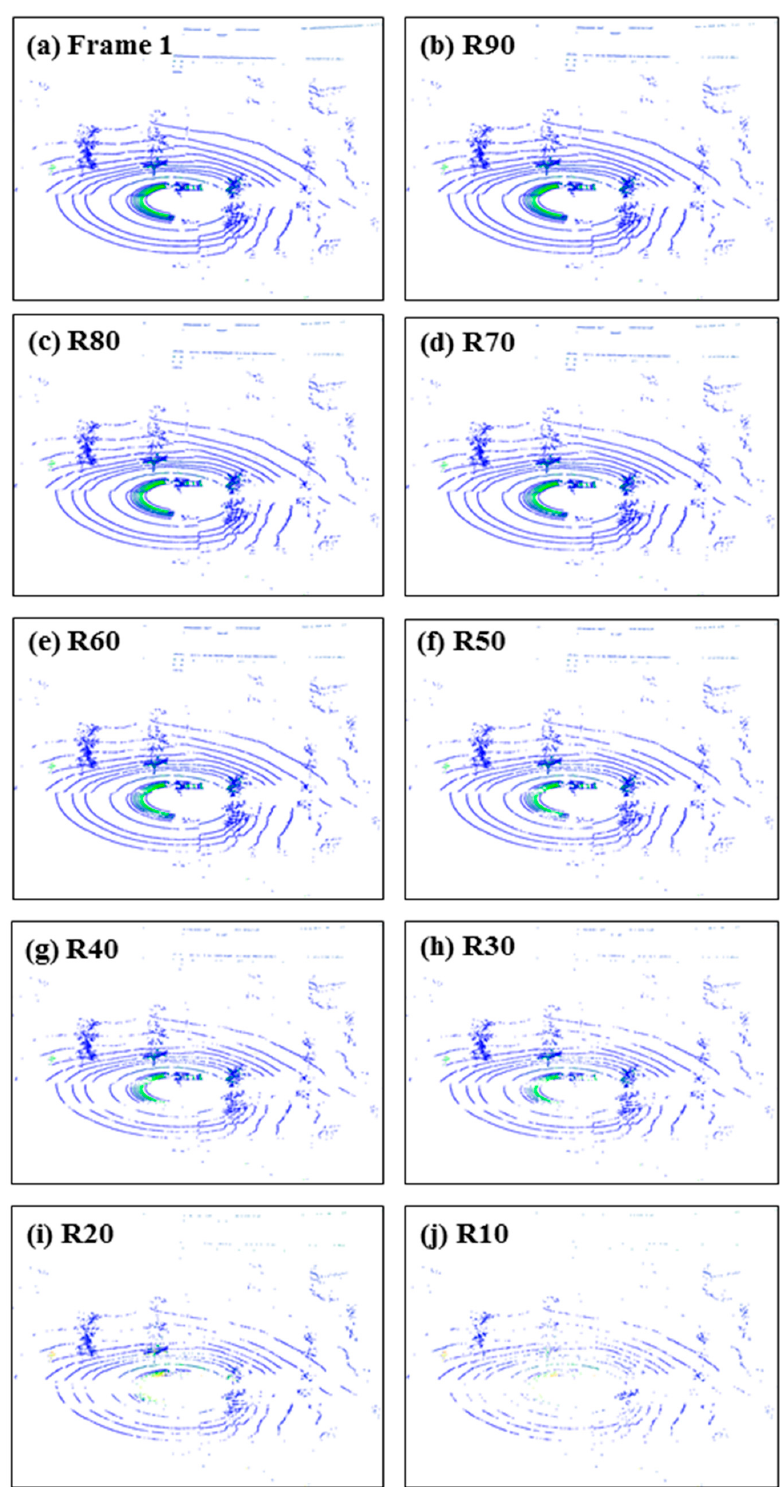
Figure 7. MLS data ( a ) original Frame 1; ( b ) 90% of points after reduction; ( c ) 80% of points after reduction; ( d ) 70% of points after reduction; ( e ) 60% of points after reduction; ( f ) 50% of points after reduction; ( g ) 40% of points after reduction; ( h ) 30% of points after reduction; ( i ) 20% of points after reduction; ( j ) 10% of points after reduction.